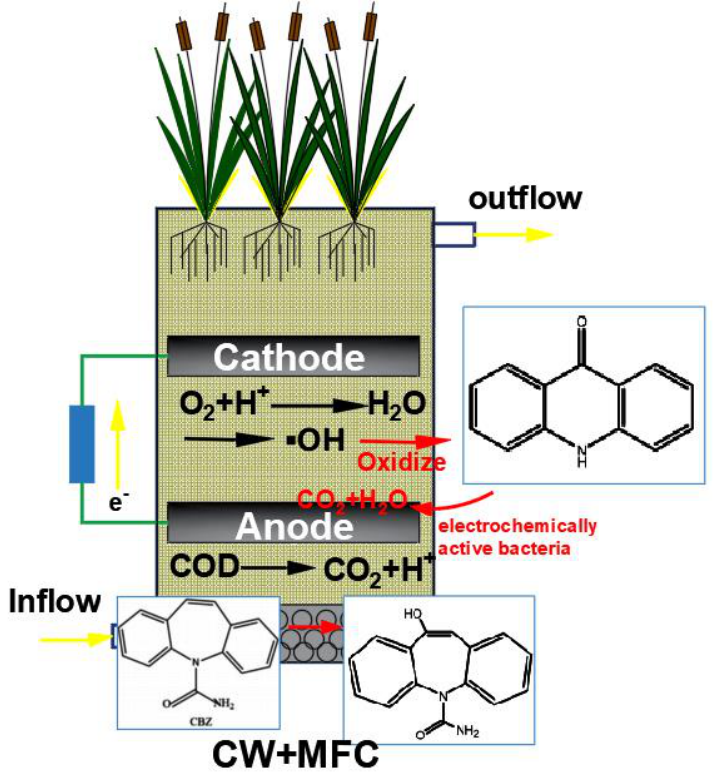
Figure 3. CBZ degradation by a CW-MFC.